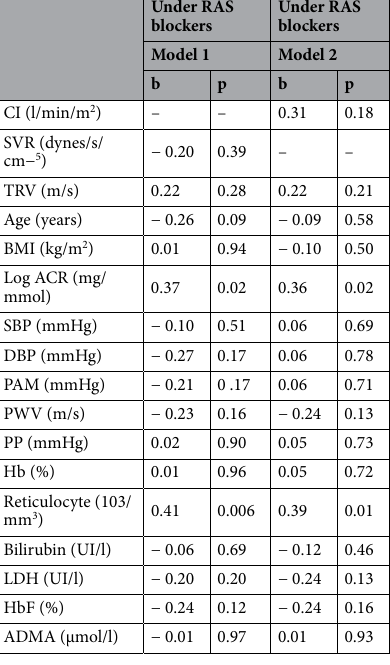
Table 4. mGFR association with different parameters under ACEI after adjustment with CI (model 1) or SVR (model